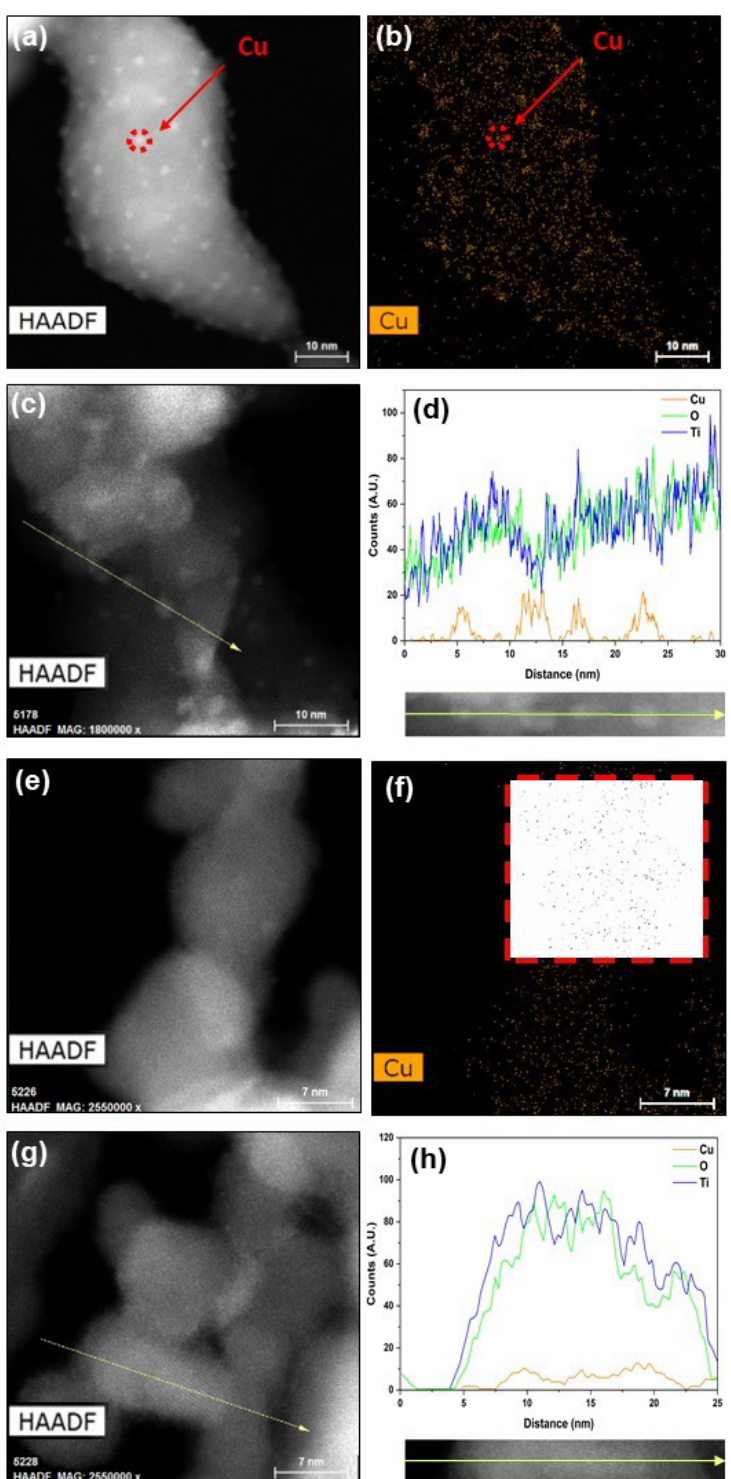
Figure 2. STEM-HAADF images and corresponding Cu elemental maps of Cu/TiO 2 -Ar ( a , b ) and Cu/TiO 2 -He ( e , f ) samples; STEM-HAADF images and associated EDS line scan analysis recorded along the yellow arrow performed on Cu/TiO 2 -Ar ( c , d ) and Cu/TiO 2 -He ( g , h ). Inset in ( f ) highlights the visualisation of Cu element (black spots on white background) by means of a treatment operated on ImageJ